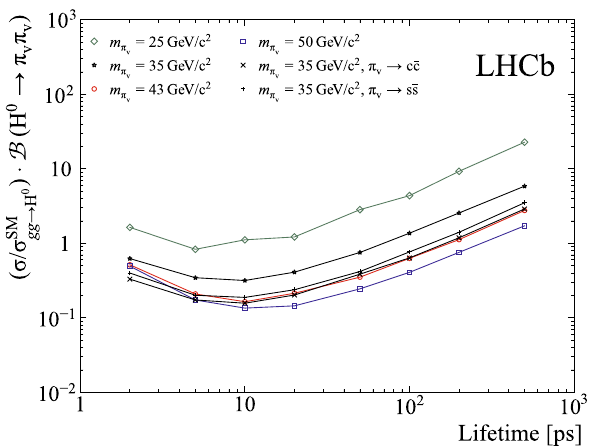
Fig. 4 Observed upper limit versus lifetime for different π v masses and decay modes. The decay π v → b ¯ b is assumed, unless specified otherwise